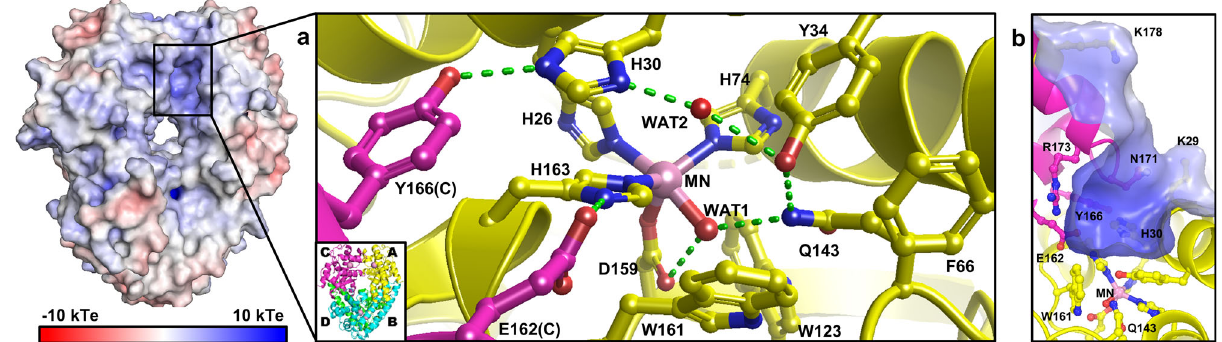
Fig. 1 Structure of tetrameric human MnSOD. a The active site of MnSOD is within a positively charged cavity formed from two adjacent subunits. The hydrogen bond network is denoted by green dashes and involves residues from both subunits. The inset indicates chain identity where A and B comprise the asymmetric unit while C and D are generated by symmetry. This chain coloring scheme is used in all the fi gures. Solvent and substrate accessibility is possible only through the ~5 Å gap between His30 and Tyr34. b Side-view of the active site cavity rotated approximately 90° relative to a . Structure is from PDB ID 5VF9 [10.2210/pdb5VF9/pdb] 77